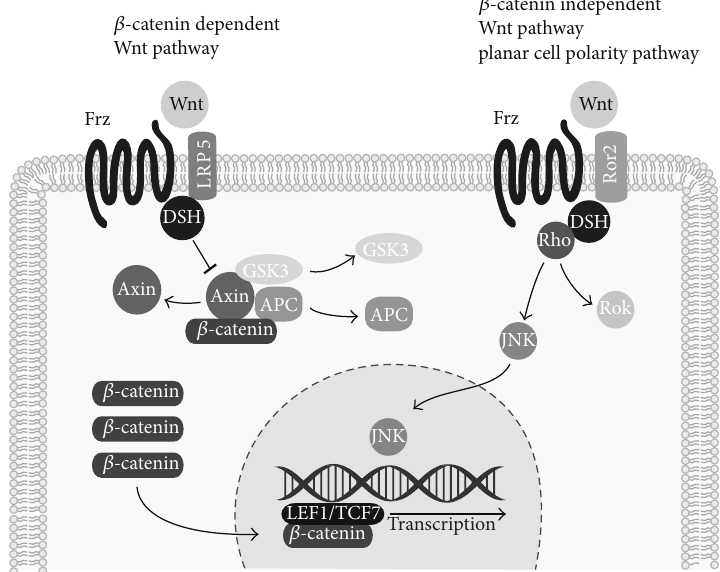
Figure 3: Schematic of 𝛽 -catenin dependent and independent Wnt signaling pathways. Wnt signaling transduction occurs via 𝛽 -catenin dependent or 𝛽 -catenin independent signaling pathways. In 𝛽 -catenin dependent signaling, extracellular Wnt ligands bind to the LRP5- Frizzled (Frz) complex to activate intracellular disheveled (DSH). This subsequently inhibits the intracellular complex comprised of axin, glycogen synthase kinase 3 (GSK3), and adenomatosis polyposis coli (APC) protein. This inhibits the cytosolic degradation of 𝛽 -catenin, which accumulates and is free to enter the nucleus to heterodimerize with lymphoid enhancer-binding factor/T cell factor (LEF/TCF1) and mediate effects of gene transcription. Under the 𝛽 -catenin independent signaling pathway, a similar transmembrane complex forms between Wnt, Frz, DSH, and Ror2 and activates secondary